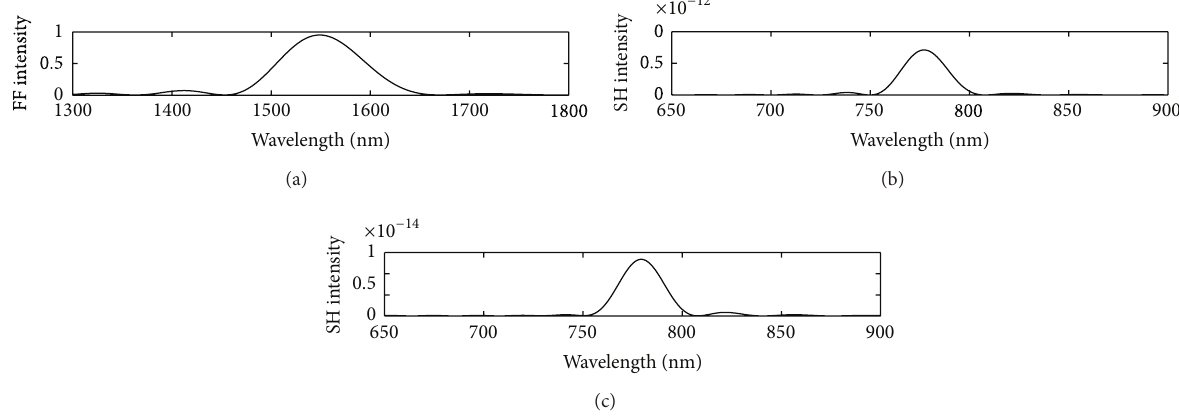
Figure 5: (a) The FTS for 𝐸 (1) 𝑦 component of fundamental frequency wave at the wavelength 1548nm. The FTS for (b) 𝐸 (2) 𝑥 and (c) 𝐸 (2) 𝑦 component of second-harmonic generation at the wavelength 774 nm.